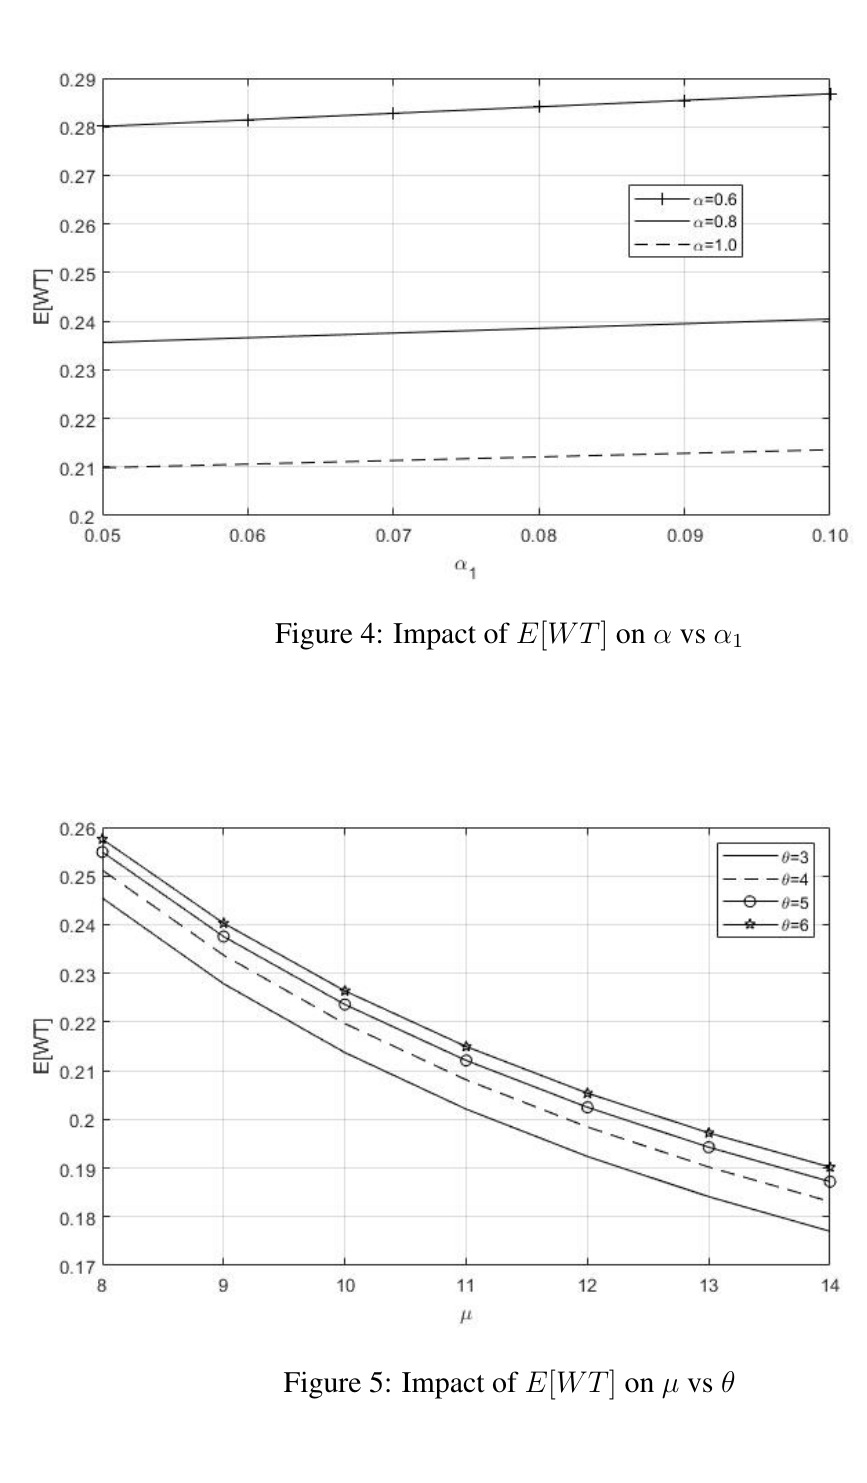
Figure 5: Impact of E [ W T ] on µ vs